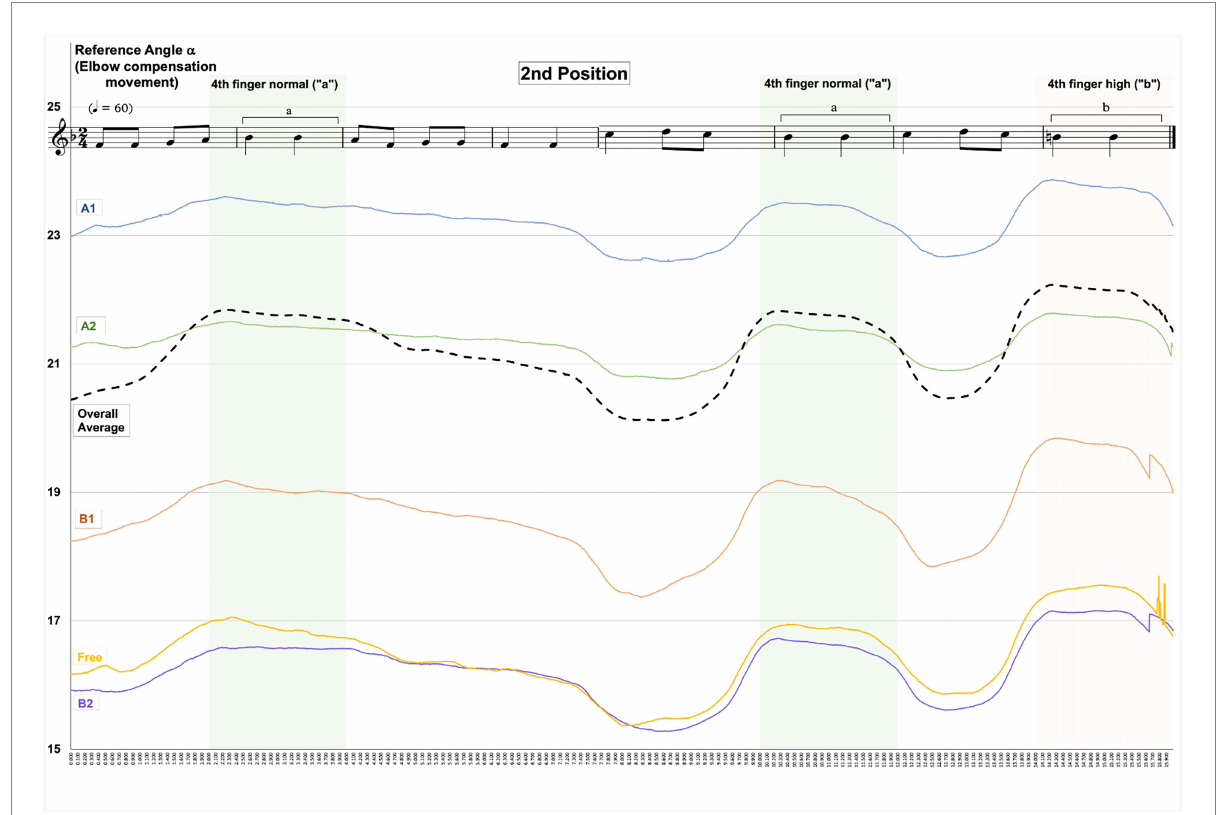
FIGURE 8 Changes in Reference Angle α by instrument position and overall mean when playing in second hand